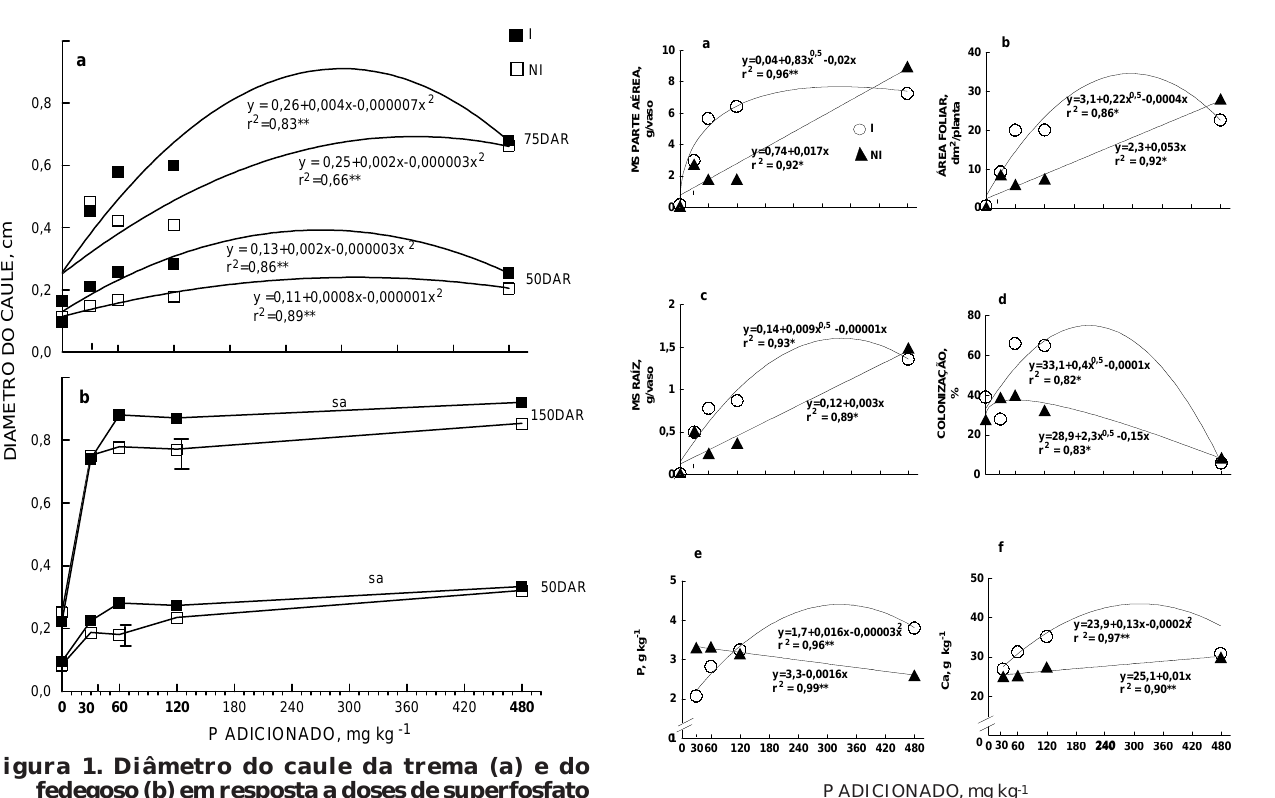
Figura 2. Respostas da trema a doses de superfosfato e à inoculação com o fungo micorrízico G. etunicatum (I- inoculado; NI- não inoculado) em latossolo vermelho-escuro de baixa fertilidade